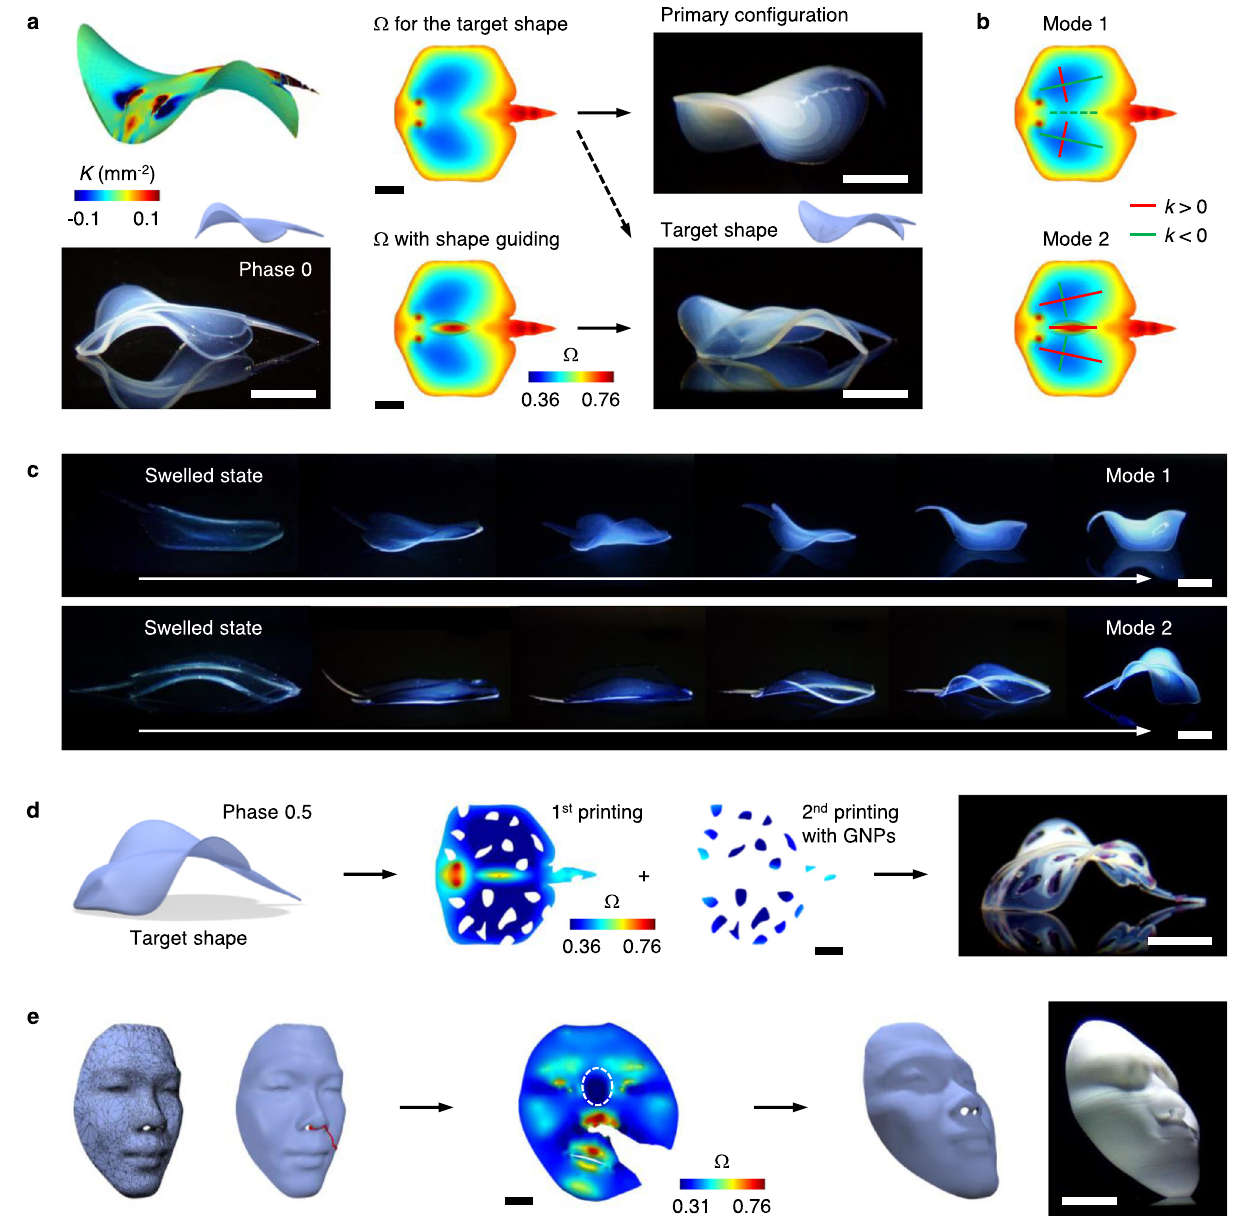
Fig. 4 Shape selection. a Formation of a stingray structure at phase 0 of undulatory swimming motion. The left panel shows the target shape with Gaussian curvature K (top) and the side view of an experimentally printed structure (inset: side view of the target shape) (bottom). The middle panel shows 2D growth Ω computed for the target shape (top) and Ω with a shape-guiding module (bottom). The right panel shows experimentally printed structures: primary con fi guration induced by Ω (top) and target shape induced by Ω with the shape-guiding module (bottom). b Two major modes of shape morphing of the fi ns. The red and green lines indicate the principal curvatures and directions with k > 0 and k < 0, respectively, where k is the curvature. c 3D shape transformation of hydrogels encoded with Ω (top) and Ω with the shape-guiding module (bottom) for a stingray structure at phase 0.5 from the swelled state to the shrunk state with time. d Formation of a stingray structure patterned with gold nanoparticles (GNPs) (shown in purple). e Replication of a real human face: reconstructed 3D shapes of a scanned face, where the red circle and line indicate a cone singularity and cutting path, respectively (left), Ω with a cone singularity computed for the face (middle), and target shape and printed structure of the face (right). Scale bars, 3 mm in a , c , and d ; 5 mm in e